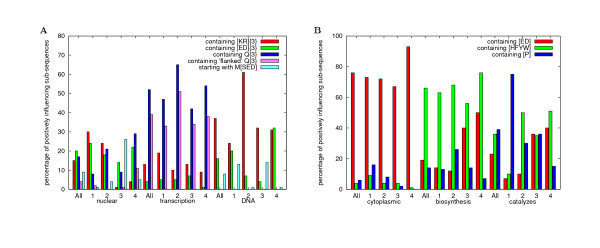
Function-related sequence features. The sequence_classifier subroutines of fixed-target predictors contain one or more evolved regular expressions which may influence the classifier in a positive or negatively way. As described in the Methods, this positive or negative influence can be determined with an approximation method. The positively influencing regular expressions are matched against test set sequences (cuts 1 to 4 of the data individually, or pooled together, indicated with "All" in the figure). The 500 most-matched residues or sequence fragments are then analysed manually for recurrent patterns. In panel A, we summarise the sequence features that are important for predictors of the functions: "nuclear", "transcription" and "DNA". As expected, sequence features containing multiple lysine and arginine residues are an important signal in nuclear proteins (the pattern [KR] {3} is found in approximately 15% of the top 500 positively influencing residues for "nuclear" predictors). Other signals thought to be involved in protein-protein interactions in the nucleus are also identified by this analysis: repeated acidic residues and polyglutamine. The polyglutamine feature, and particularly polyglutamine flanked by at least one of the residues D/R/H/A/N/K/S/L/E/P/T, is a stronger signal for "transcription" predictors. In panel B, the same analysis is performed for predictors of "cytoplasmic", "biosynthesis" and "catalyzes". In this case only single-residue "features" are apparent from the data. For instance, aromatic residues are more important for predictors of "biosynthesis" and "catalyzes" than for "cytoplasmic" (green bars).